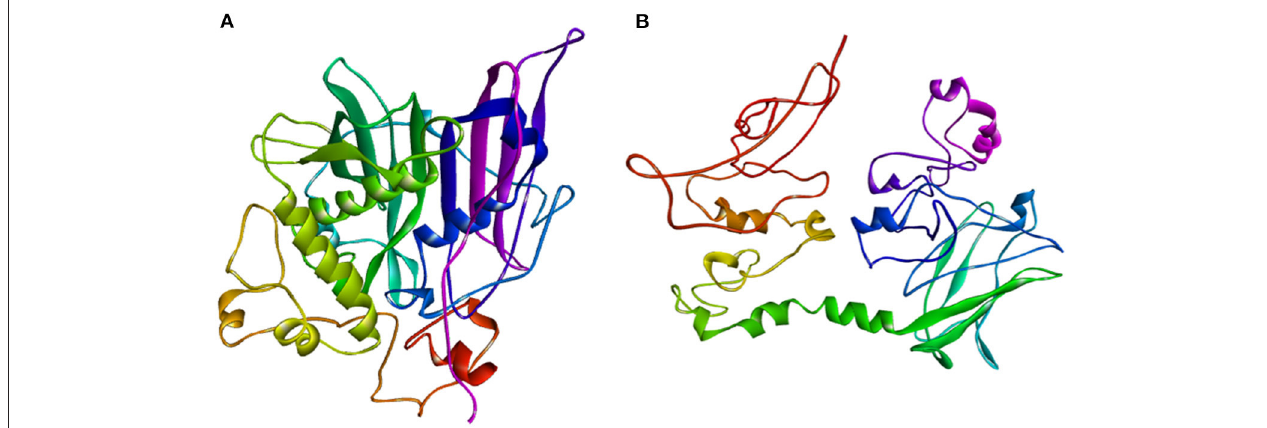
FIGURE 5 | Thread based homology models of (A) mutant protein (ZmFATB-B73-Mutant); (B) wild type [ZmFATB-Wild1 (PMI-Bio-101)] protein obtained through